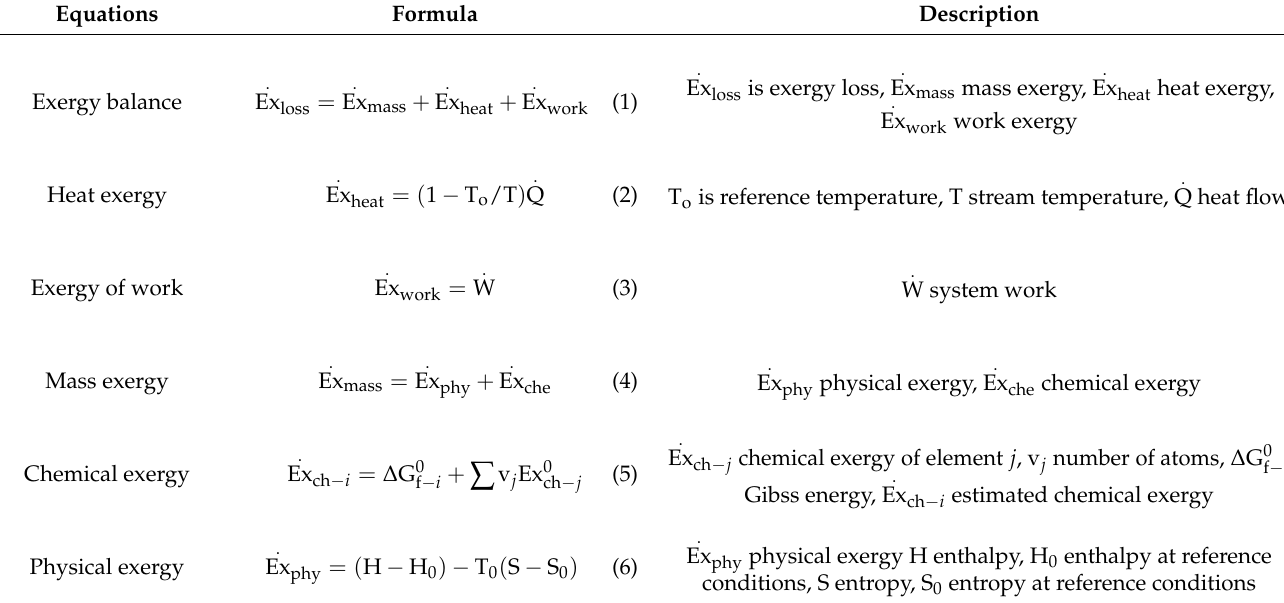
Table 2. Governing equations of exergy